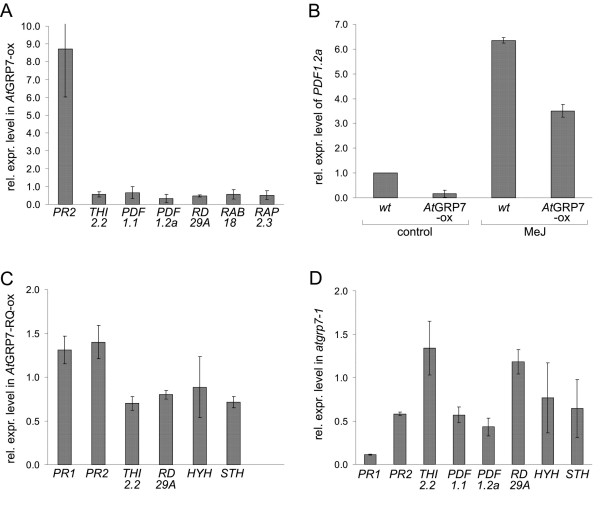
Analysis of selected AtGRP7 candidate target transcripts in transgenic lines with elevated or reduced AtGRP7 levels. A) AtGRP7-ox and wt plants were grown in LDs and harvested around the circadian maximum. Expression levels were determined by qRT-PCR and normalized to PTB expression. Shown is the expression in AtGRP7-ox plants relative to wt. B) Transcript levels of the JA-responsive PDF1.2a in MeJ-treated plants. Independent AtGRP7-ox lines and the corresponding wt plants were grown in liquid culture in LDs and harvested 24 h after MeJ treatment. Expression levels were determined by qRT-PCR and normalized to PTB. The level in untreated wt plants is set to 1. C) Mutation of a conserved arginine in the AtGRP7 RNA recognition motif interferes with regulation of target transcripts. qRT-PCR was performed on RNA from AtGRP7-RQ-ox and wt plants grown in LDs and harvested at zt12 for the analysis of PR1, PR2, THI2.2 and RD29A, and at zt3 for the analysis of HYH and STH, respectively. Data were normalized to PTB and the levels in AtGRP7-RQ-ox plants are expressed relative to wt. D) qRT-PCR was performed on RNA from the T-DNA line atgrp7-1 and Col-0 wt plants grown in LDs and harvested at zt12 for the analysis of PR1, PR2, THI2.2, PDF1.1, PDF1.2a and RD29A, and at zt3 for the analysis of HYH and STH, respectively. Data were normalized to PTB and the levels in atgrp7-1 are expressed relative to wt.